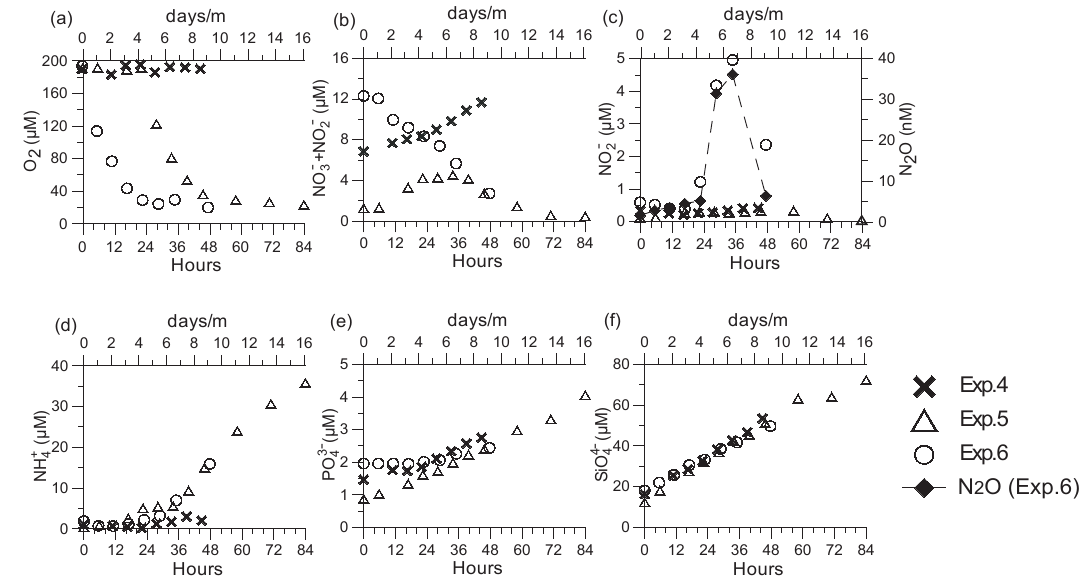
Fig. 4.. Figure 4. Variation of parameters with the integral of time/water column height (in days/meter) in the incubations during April 2006: (a) Fig. 4.. + NO − dissolved oxygen, (b) NO − , (c) NO − and N 2 O, (d) NH + 3 2 2